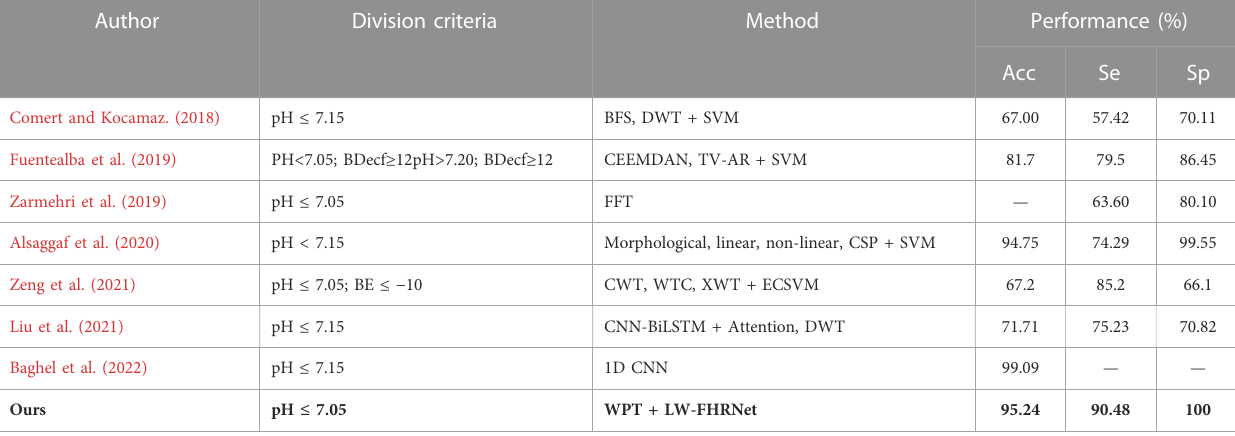
TABLE 6 Comparison of recent studies on the prediction of fetal distress using the CTU-UHB database.